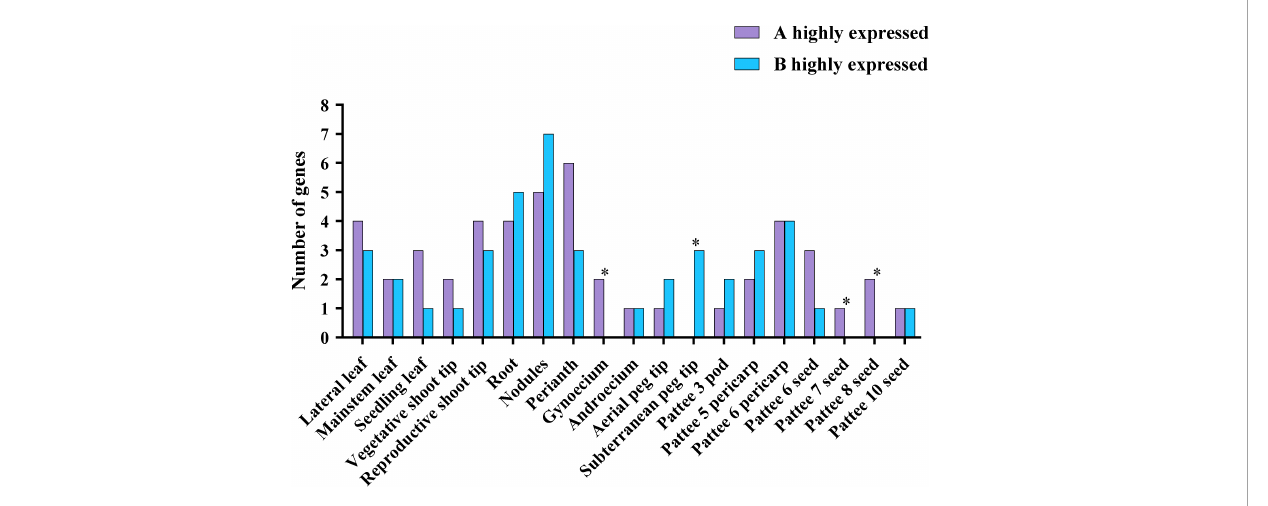
FIGURE 7 Differential expression of R2R3-MYB homologous genes in A. hypogaea cv. Tifrunner. To look for variations in the levels of gene expression in 19 distinct organs, homeologs were compared. Each subgenome was represented by the number of homeologous genes that were more strongly expressed (log2 fold change ≥ 1, Benjamini-Hochberg adjusted P < 0.05; Wald test) in each subgenome is represented. P-value correspond to binomial test with the odds of A genes being more highly expressed at 0.5 probability. *P < 0.05, others : not signi fi